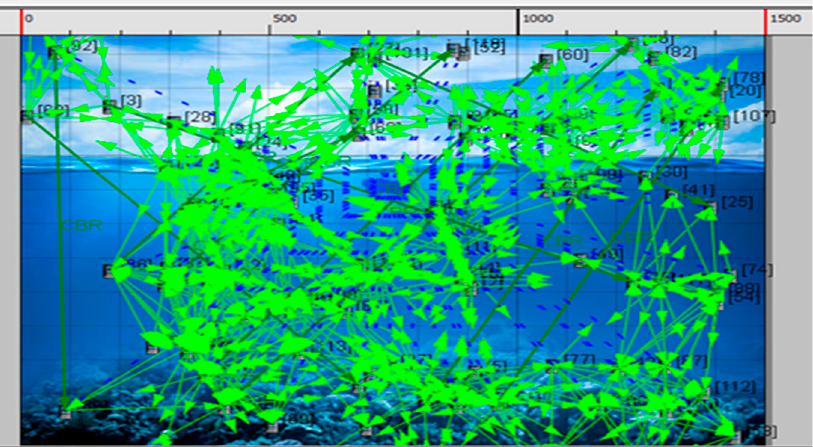
Figure 7. Runtime underwater wireless communication with 120 nodes in X-Y visualization .